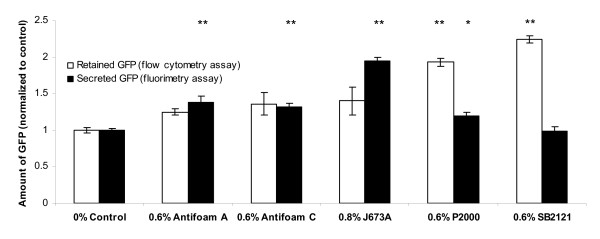
Antifoam addition can affect both retained and secreted GFP. The amount of GFP retained in the cell was analyzed by flow cytometry (white bars), while that secreted into the culture medium was analyzed by fluorimetry (black bars). In order to compare these two different data sets, each was normalized to its respective 0% antifoam control, which was consequently set to 1. The values shown are for determinations at 48 h (n = 3). The significance of the changes in retained (white bars) and/or secreted (black bars) GFP compared to the respective 0% antifoam control was analyzed by a one-way ANOVA (P < 0.0001) and a Dunnett's multiple comparison test where * = P ≤ 0.05 and ** = P ≤ 0.01.